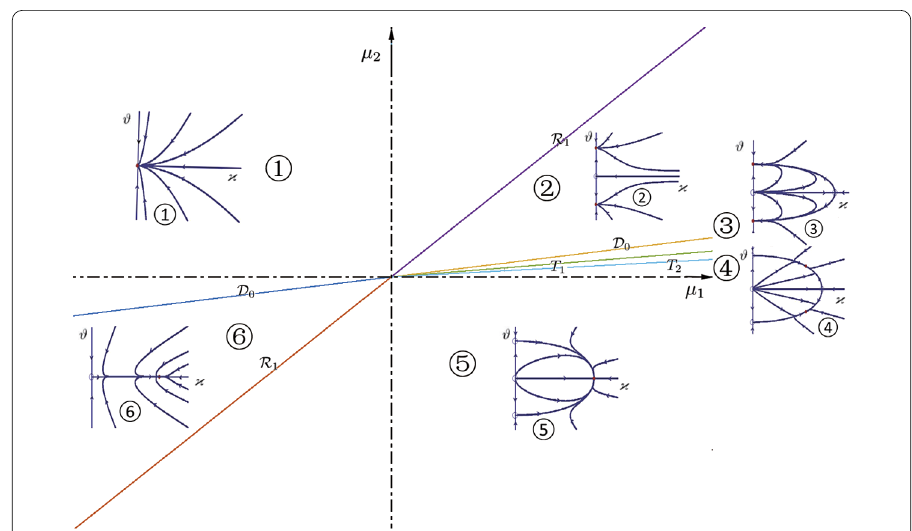
Figure 2 Bifurcation diagrams and dynamical classification near the Turing–Hopf point. The yellow line and mazarine line are D 0 ; the purple line and red line are R 1 ; the green line is T 1 ; the blue line is T